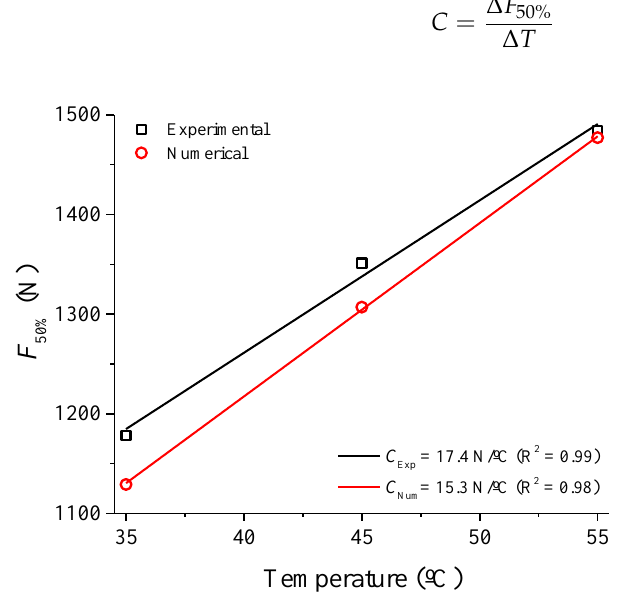
Figure 16. Experimental vs. numerical linear increase of F 50% as a function of temperature.